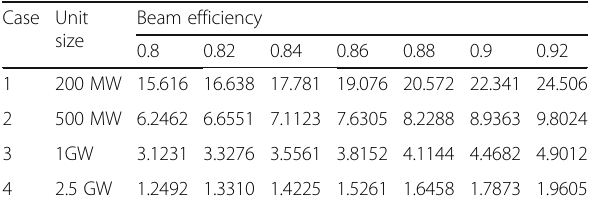
Table 2 Antenna size × 10 5 m 2 at 2.45 GHz with different beam